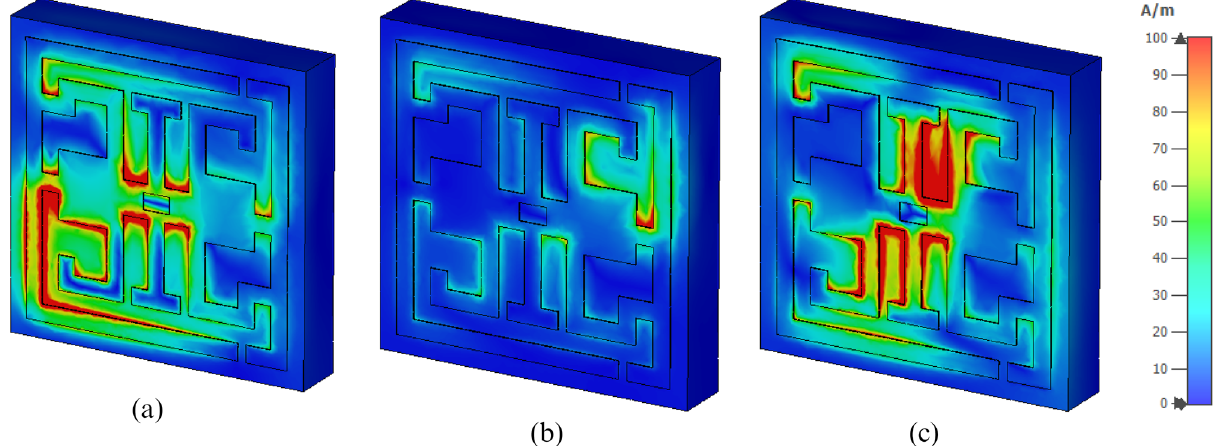
Figure 6. Magnetic field ( a ) 3.94 GHz, ( b ) 8.08 GHz, ( c ) 11.175 GHz (CST STUDIO SUITE 2019, https:// www. 3ds. com/ produ cts- servi ces/ simul ia/ produ cts/ cst- studio- suite) 30 .